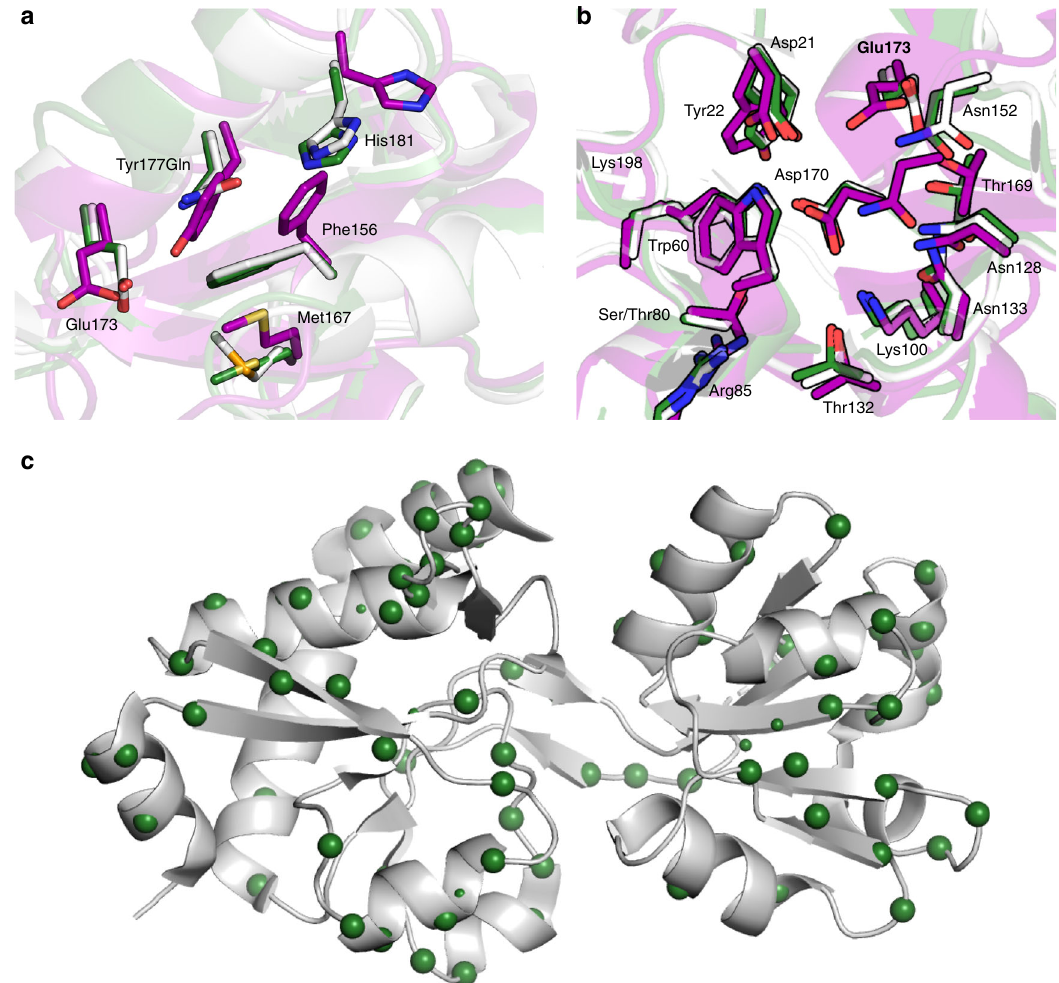
Fig. 2 Crystal structures of AncCDT-3/P188, AncCDT-5 and P a CDT. a Structural overlay of the small domains of AncCDT-3/L188 (purple, PDB 5JOS), AncCDT-5 (green) and Pa CDT (white, PDB 3KBR). The Tyr177Gln substitution that occurs between AncCDT-3 and AncCDT-5 contributes to the repositioning of Glu173. b Structural alignment of the active sites of AncCDT-3/L188 (purple, PDB 5JOS), AncCDT-5 (green) and Pa CDT (PDB 3KBR, white). The small domain (residues 99 – 194) and large domain (residues 1 – 98 and 195 – 236) of AncCDT-3/L188 and AncCDT-5 were individually aligned with the corresponding domains of Pa CDT. The sidechains of the 15 inner-shell residues identi fi ed by Clifton et al. 40 are shown as sticks (Gly131 not shown), highlighting identical active site residues and side-chain conformations between AncCDT-5 and Pa CDT. The HEPES molecules present in the crystal structures are omitted for clarity. c The locations of the substitutions (green spheres) between AncCDT-5 and Pa CDT are shown projected onto the structure of Pa CDT (PDB